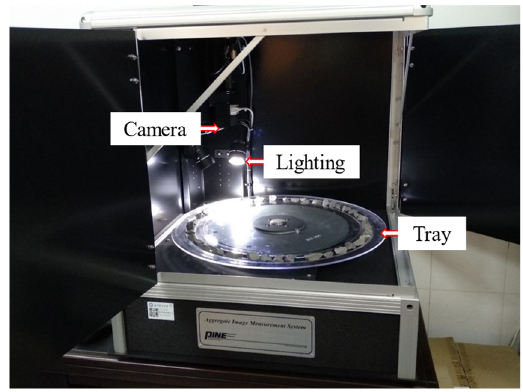
Figure 4. AIMS system.